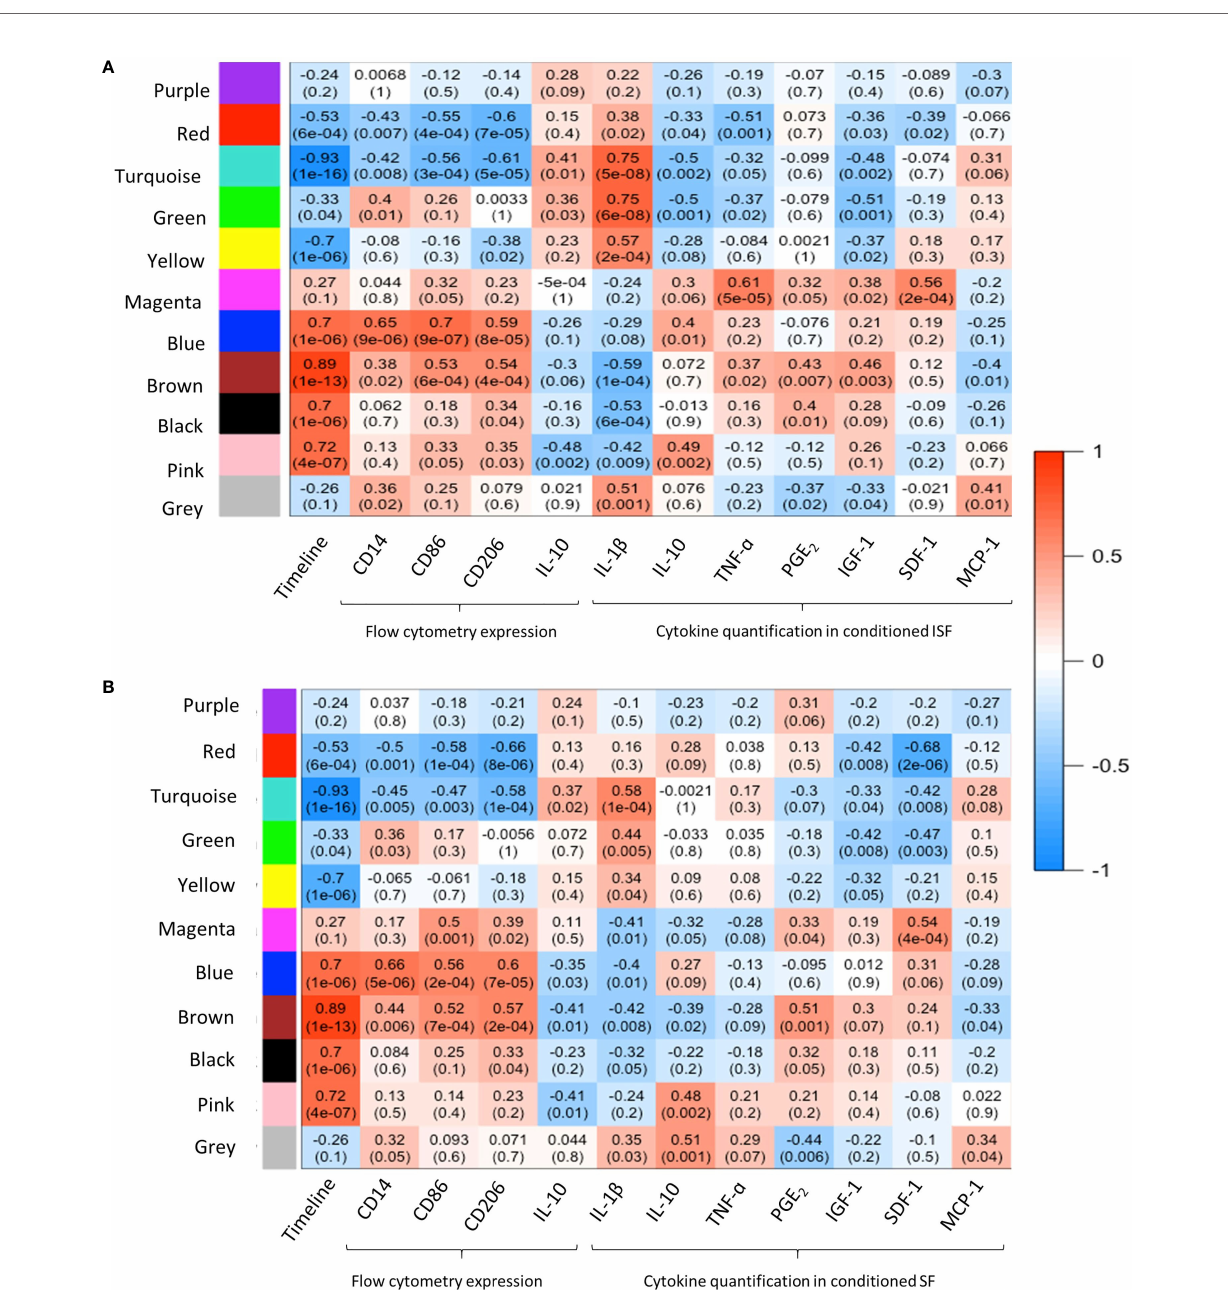
FIGURE 4 | Weighted gene co-expression network analysis (WGCNA): module-trait relationships. (A) WGCNA of 18,038 genes in ISF identi fi ed 11 modules eigengene (ME), of which 6 were positively associated (R 2 ≥ 0.7, p= ≤ 005) with the assigned traits. The turquoise and green modules were positively associated with IL-1 b quanti fi cation in ISF conditioned by BMNC. MEs blue, brown, black and pink were positively associated with the timeline. The blue module was also associated with CD86 expression assessed by fl ow cytometry (29). (B) In the SF dataset, analysis of the 16,318 genes identi fi ed the same 11 gene modules; however, timeline was the only trait with a positive association to MEs blue, brown, black and pink modules, as in